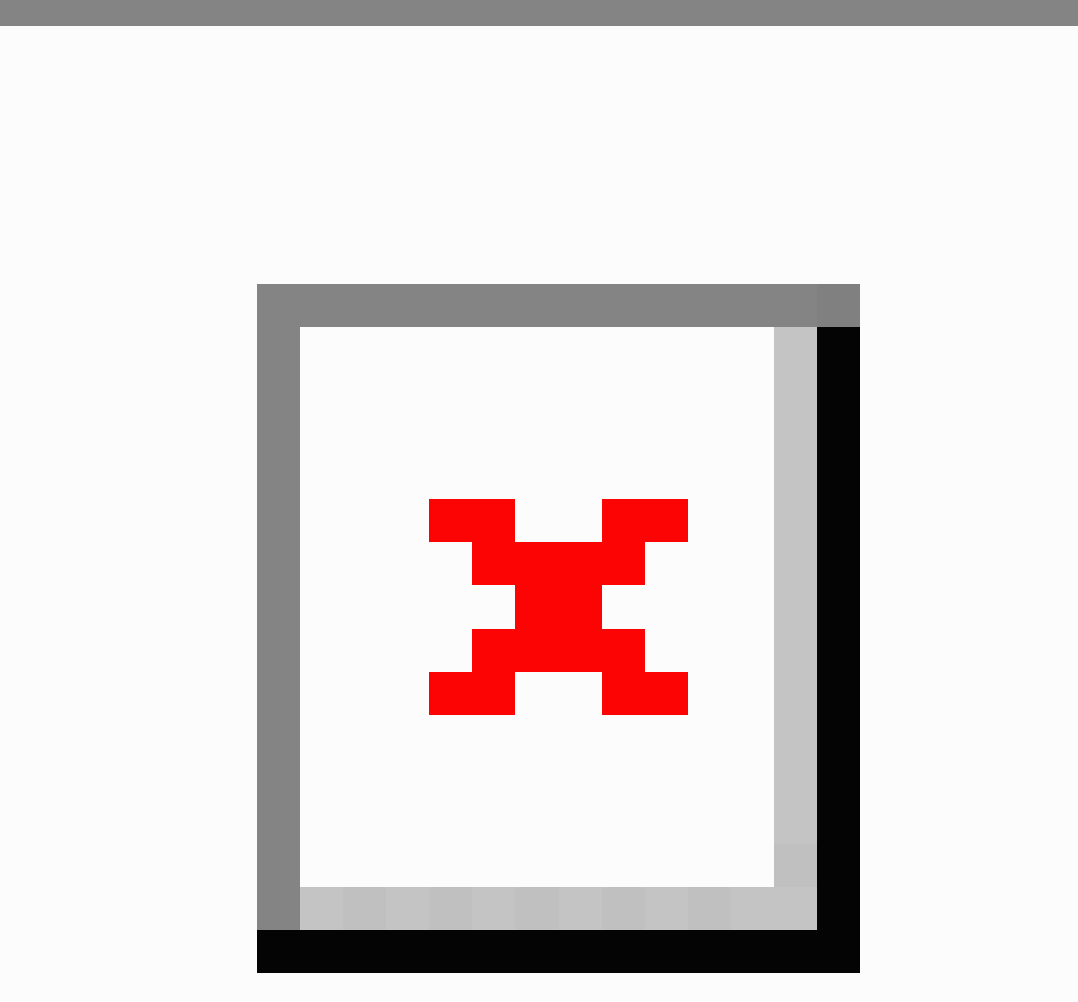
Figure 3. Relative search interest level for the term ‘‘suicide’’during the school closure period in selected countries. The dashed vertical line indicates the national school closure date. UK: United Kingdom; USA: United States of